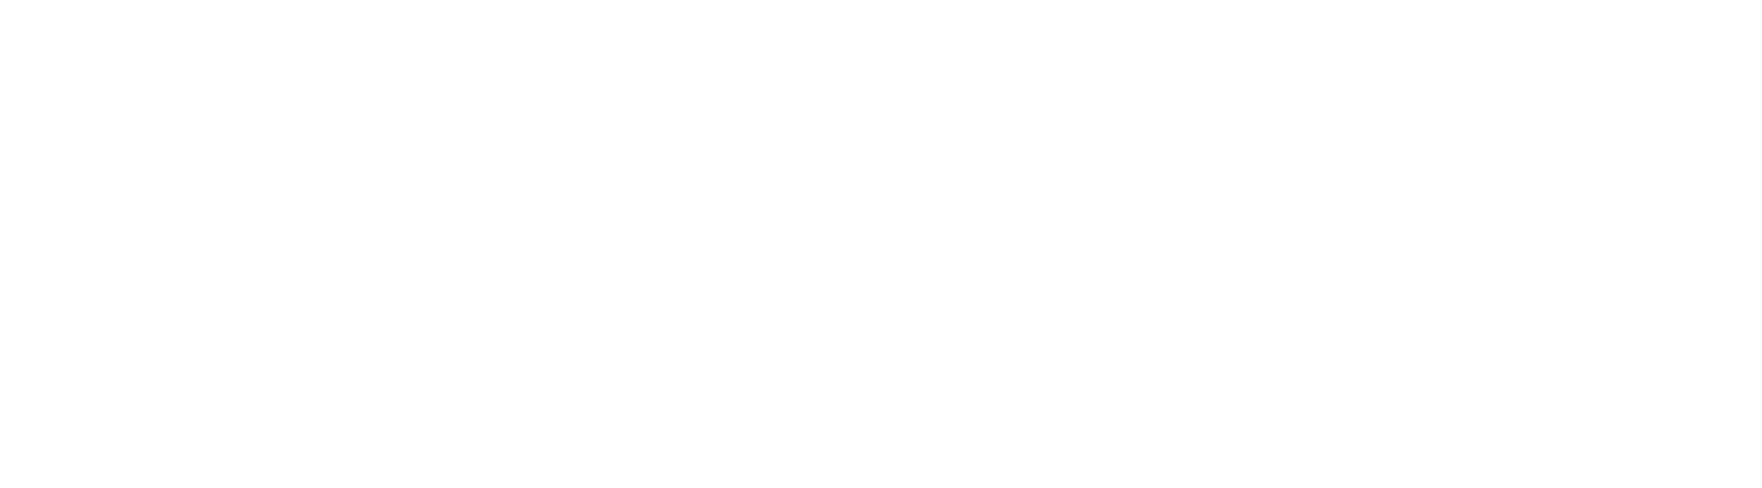
mosaic ceramic tiles Roofs